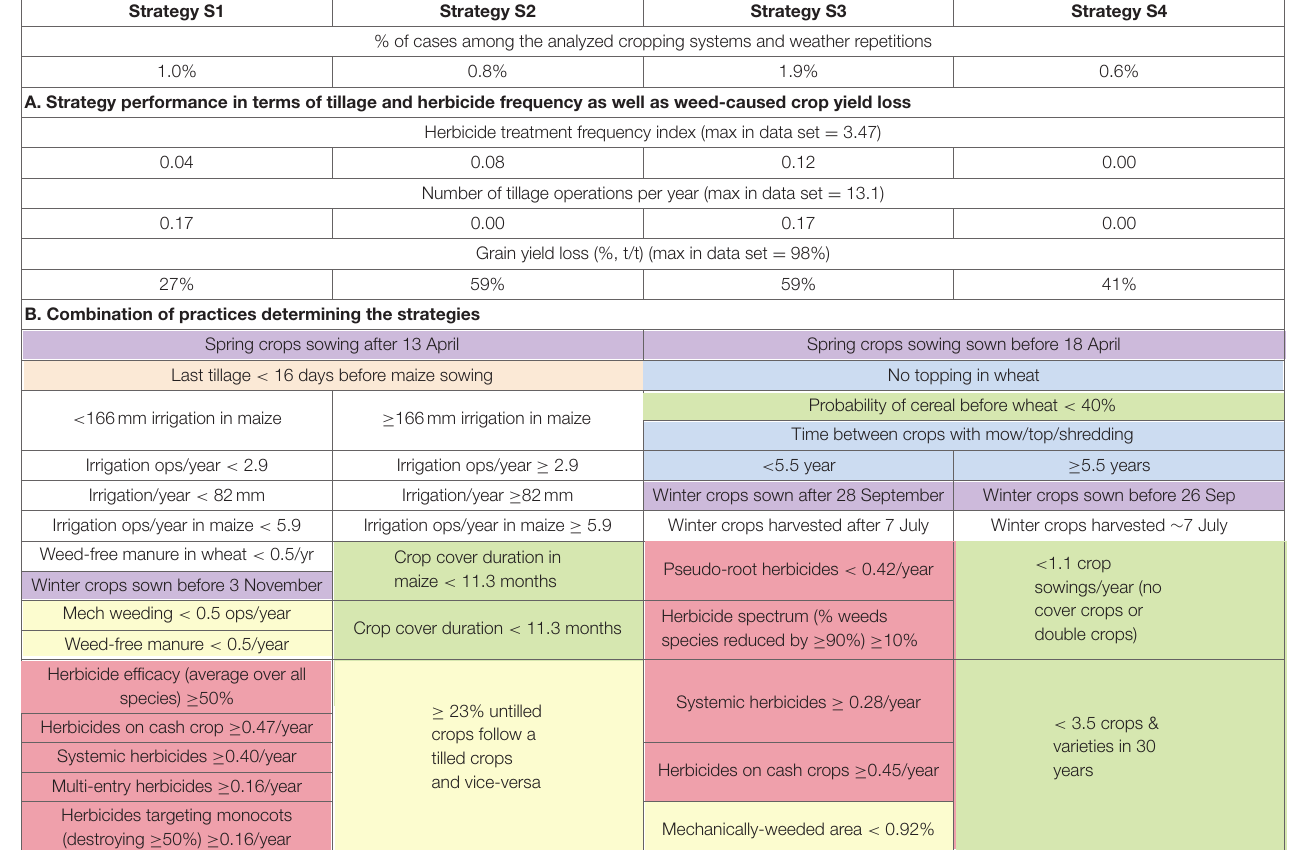
TABLE 7 | How to reconcile reduced tillage, reduced herbicide use intensity, and reduced grain yield loss due to weeds? The four strategies with herbicide use intensity < 0.15 and tillage frequency < 0.2 operations per year. Results from multi-variate classification and regression tree analyzing grain yield loss, number of tillage operations per year and herbicide treatment frequency as a function of cropping-system characteristics, with partial R ² calculated from Variable Importance Predictors and showing the probability that an increase in a cropping-system variable leads to an increase in the mean of the three response variables [normed to (0 = lowest value in data set, 1 = highest value in data set)]. Cell colors distinguish variables in relation to rotation (green), tillage/mechanical weeding (yellow), herbicides (red), sowing (purple), crop-residue shredding, mowing and topping (blue), and other (white). All values are averages over